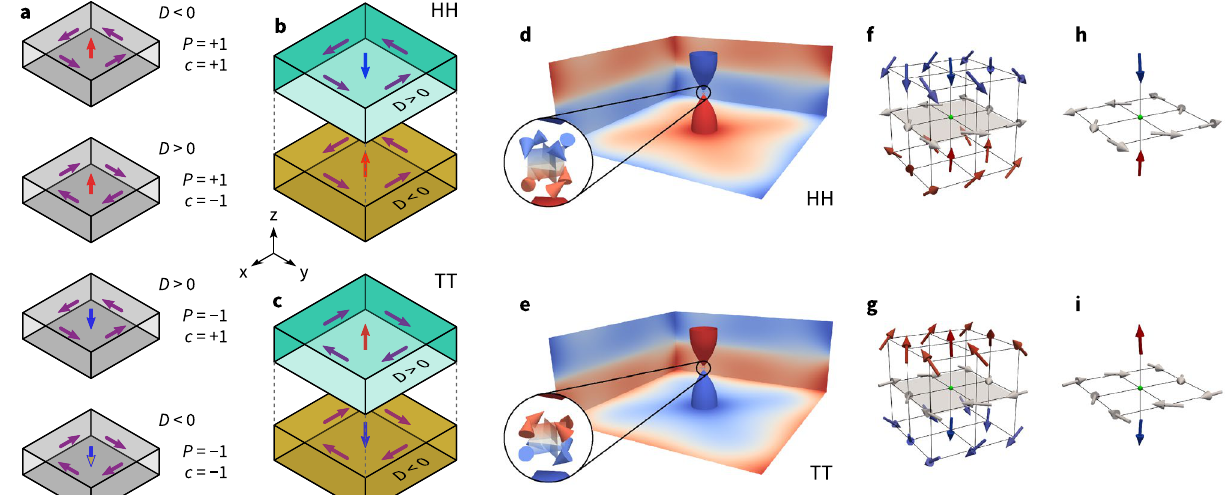
Figure 1. ( a ) In a single layer of magnetic material four different vortices, with polarisation P = ± 1 and circularity c = ± 1 , can form as a consequence of the competition between exchange energy and demagnetisation. Adding DMI couples circularity and polarisation. ( b , c ) By stacking two layers with opposite sign of the DM energy constant D , a Bloch point can be stabilised. The Bloch point can be of type head-to-head ( b ) or tail-to-tail ( c ). In the figure, the two layers are, for better clarity, separated in z direction as indicated by the grey dashed lines. ( d , e ) Simulation result for a single head-to-head ( d ) and tail-to-tail ( e ) Bloch point. The isosurfaces (of paraboloidal-like shape) near the centre show m z = ± 0.9 , colour indicates the z component. They are convenient to locate the Bloch point that is situated between them. The insets show three isosurfaces for m x = 0 , m y = 0 , and m z = 0 , respectively. The Bloch point is located at the intersection of the three isosurfaces where the magnetisation vanishes. The cones in the insets indicate the magnetisation directions in the eight discretisation cells surrounding the Bloch point. The magnetisation around the Bloch point is show in more details in ( f , h ) for the HH configuration and in ( g , i ) for the TT configuration. See the main text for additional